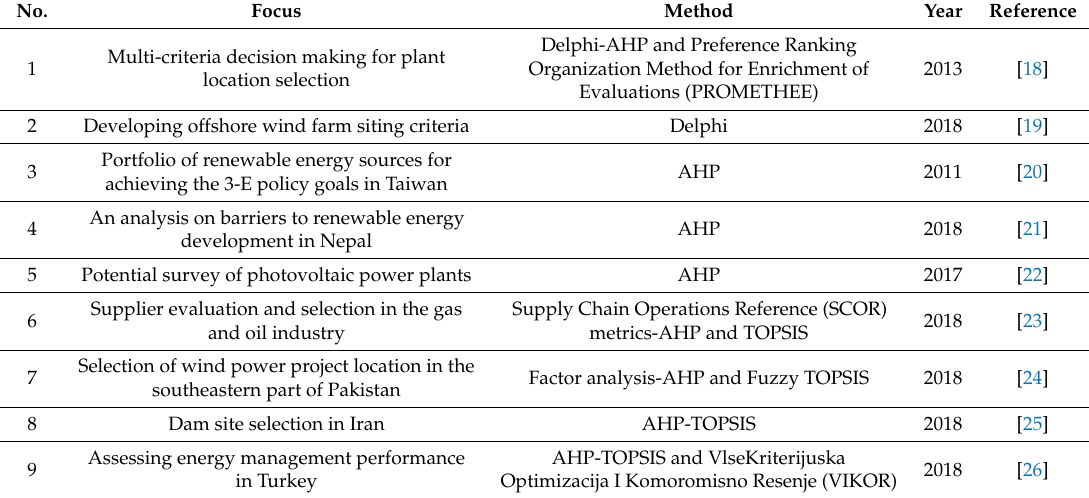
Table 1. The summary of various energy related studies with multi-criteria